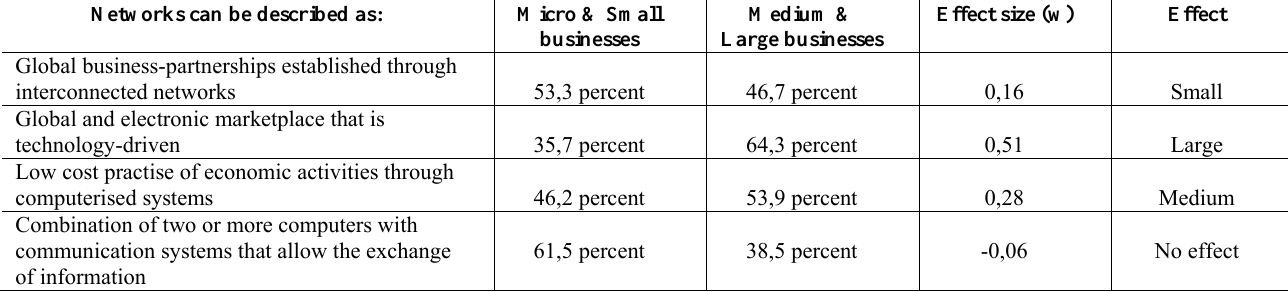
Table 4: Understanding of networks amongst different business sectors Networks can be described as: